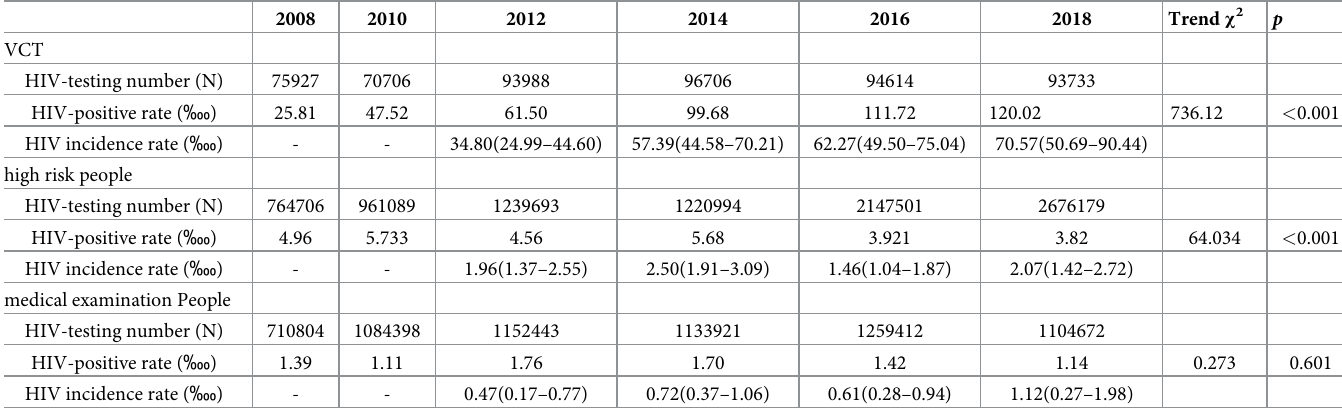
Table 3. Number and HIV screening, HIV positive rate and HIV incidence rate among population in non-medical institution.